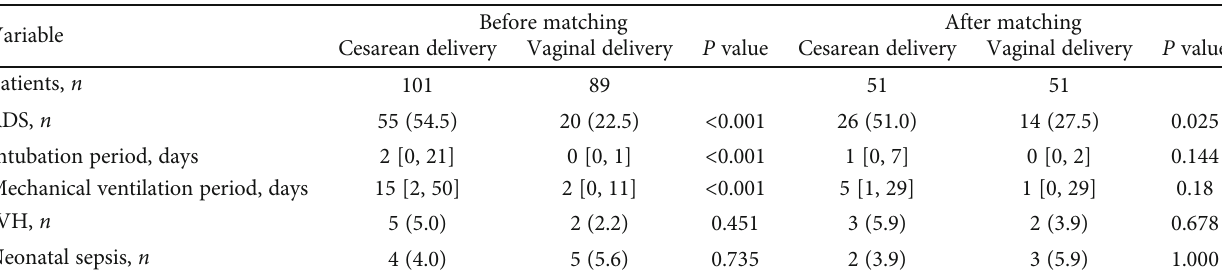
Figure 2: Standardized di ff erences plot before and after propensity score Table 2: Neonatal outcomes before and after matching.